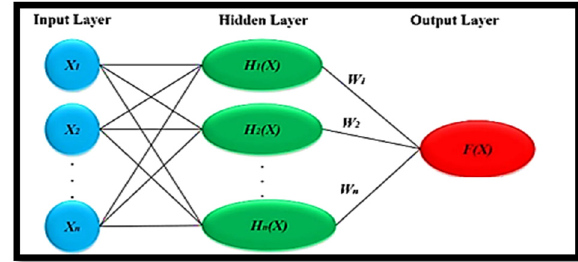
Figure 2: The diagram of ANN [ 15 ] .